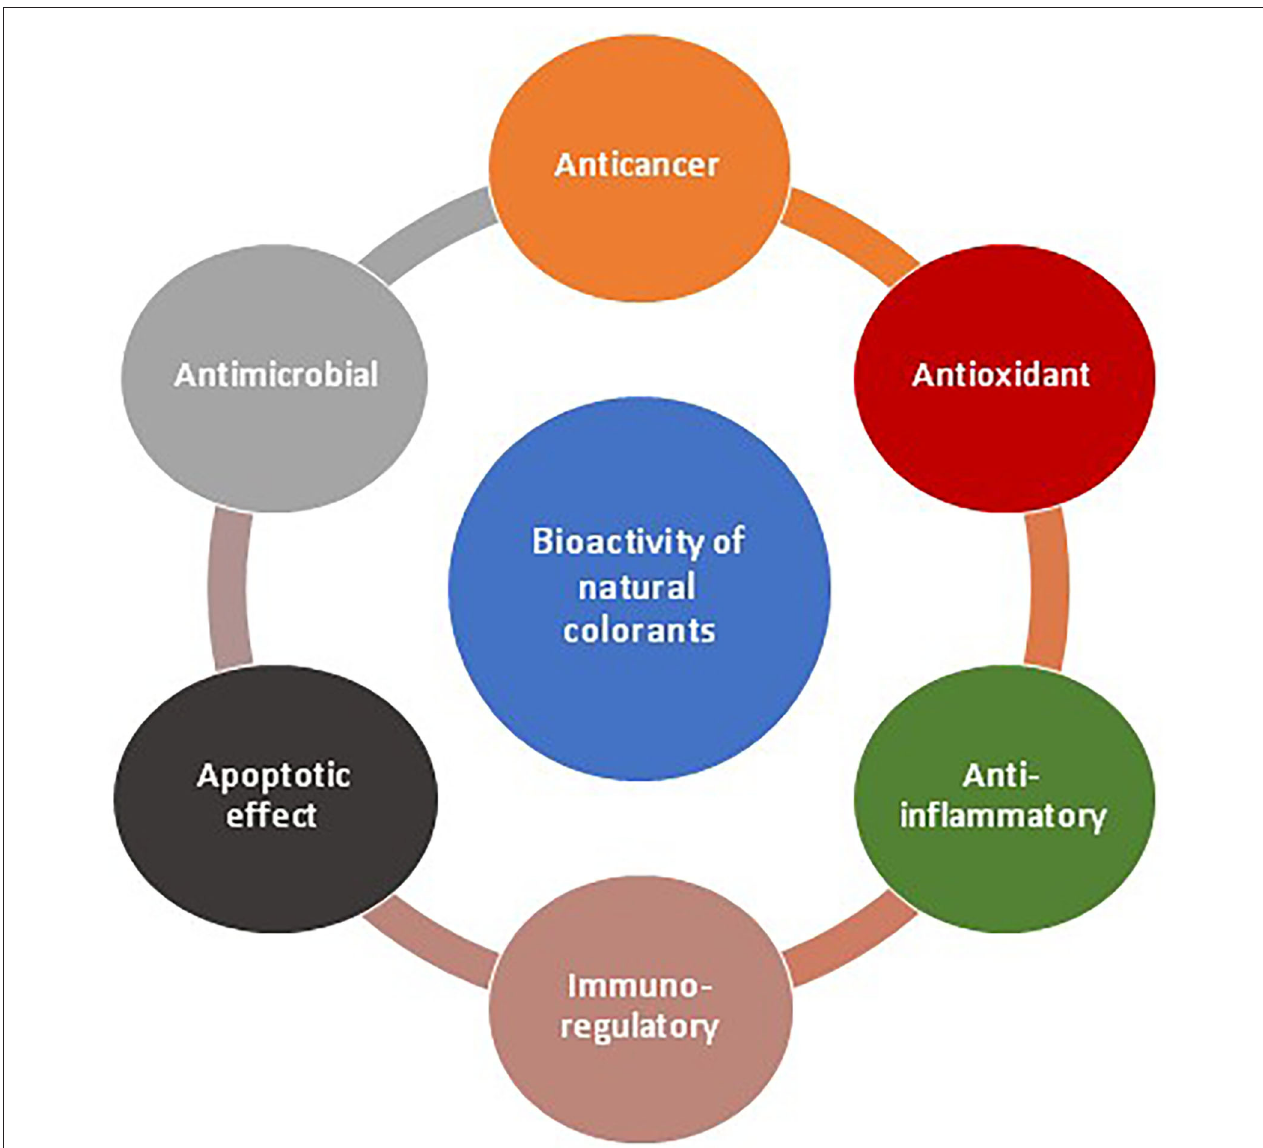
FIGURE 1 | Benefits of natural pigments as food